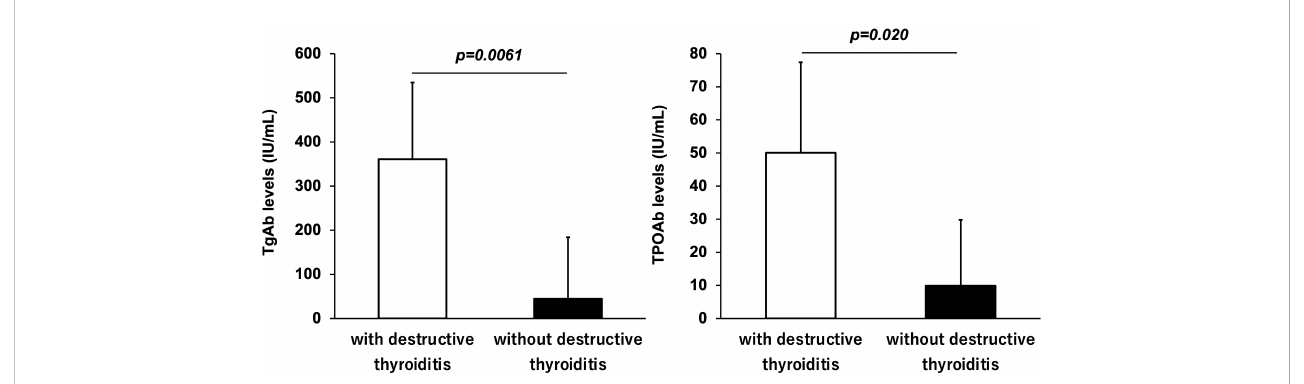
FIGURE 2 Antithyroglobulin antibody (TgAb) and antithyroid peroxidase antibody (TPOAb) levels in subjects with and without destructive thyroiditis. TgAb and TPOAb levels were signi fi cantly higher in participants who developed destructive thyroiditis than those without it (p < 0.05,